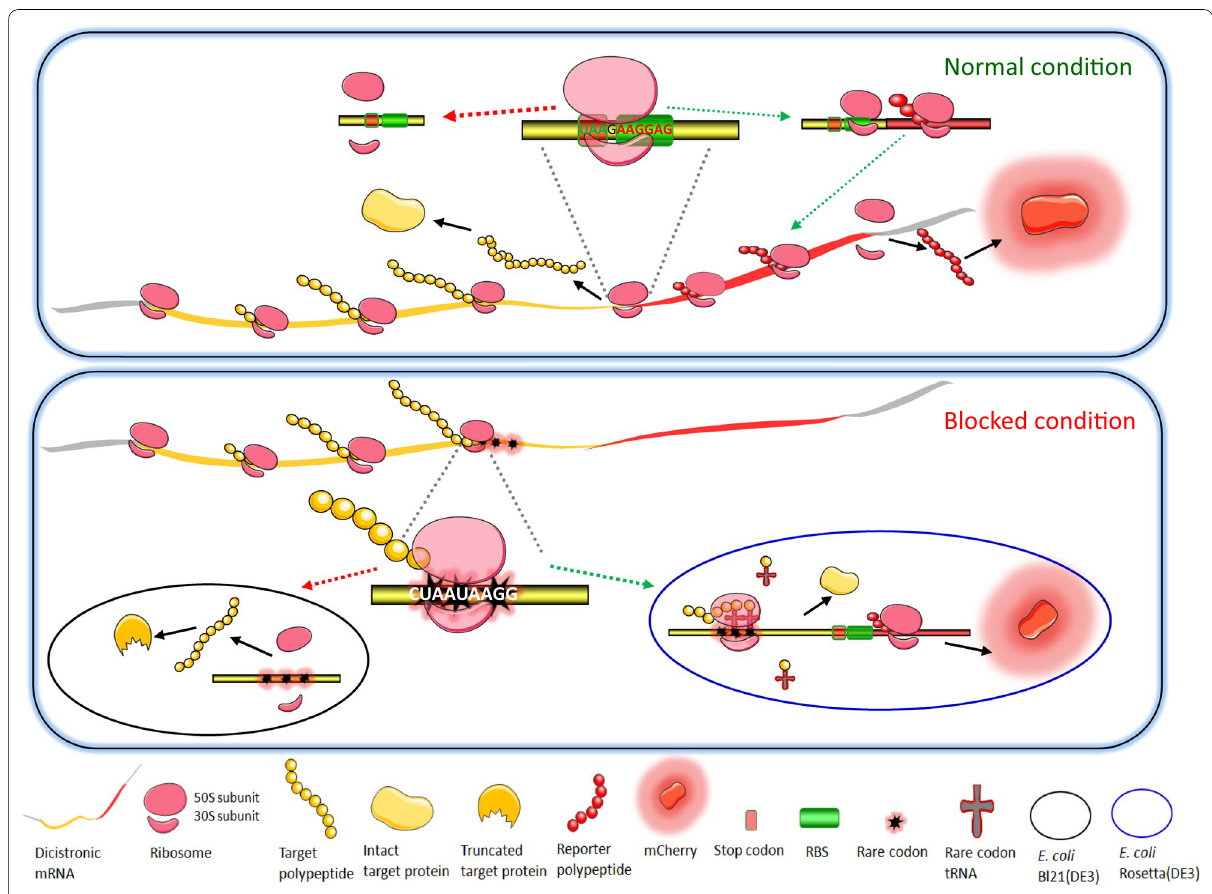
Fig. 5 A dicistronic construction‑based fluorescence indication of the target gene